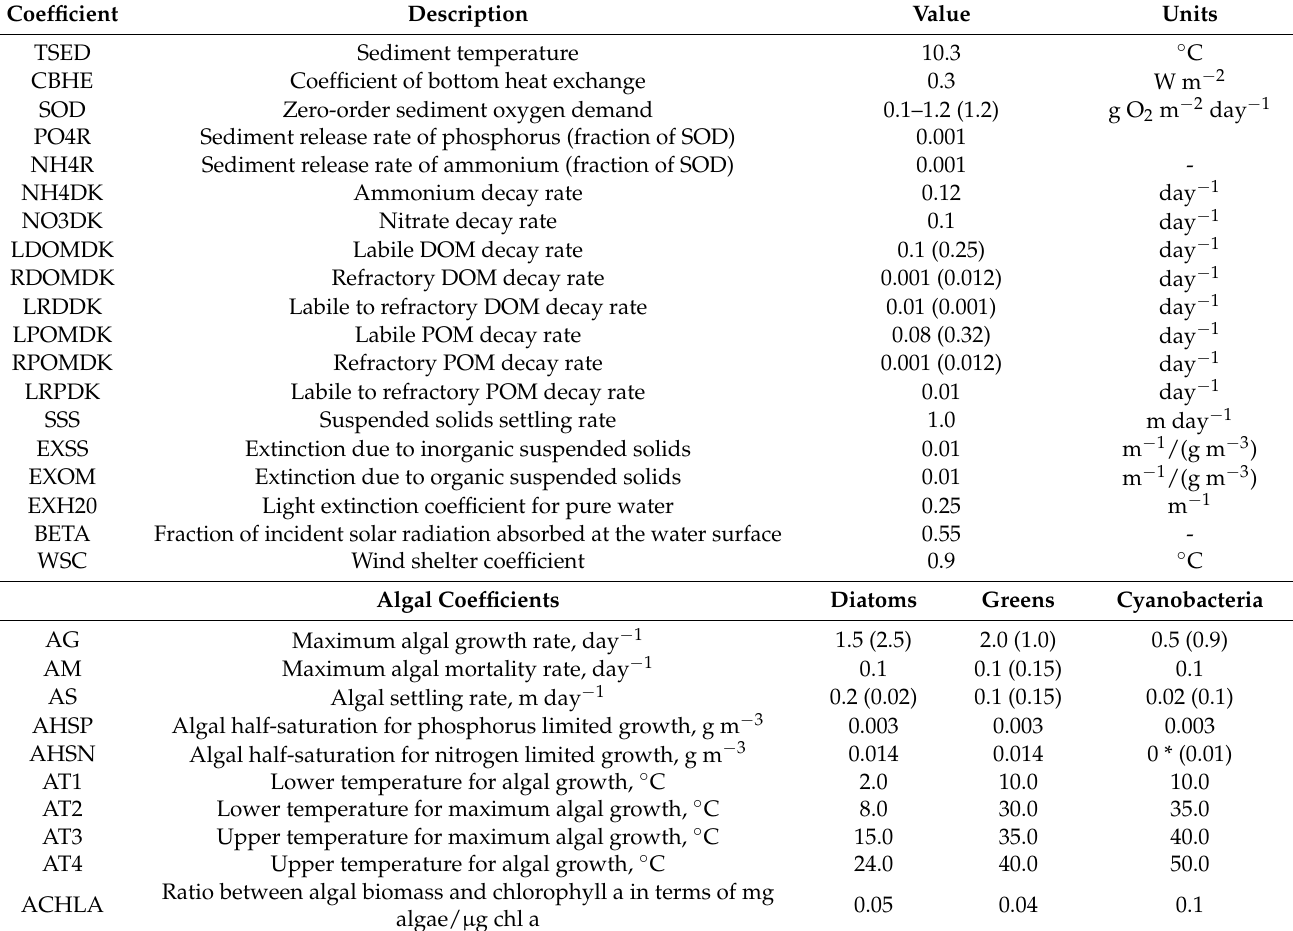
Table 1. Main coefficients used in the water quality model (previous model rates in parentheses if changed) from Terry and Lindenschmidt